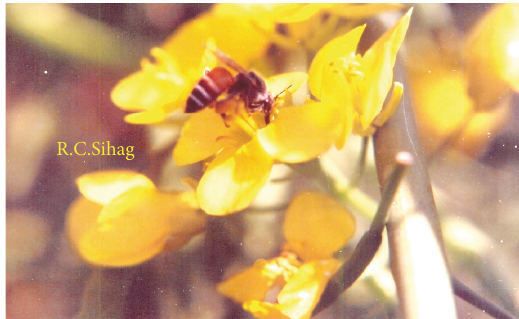
Figure 2: A forager of the dwarf honeybee ( Apis florea F.) collecting nectar as well as pollen from the top/front of the flower of rape toria ( Brassica campestris L. var. toria) (NP1-forager).